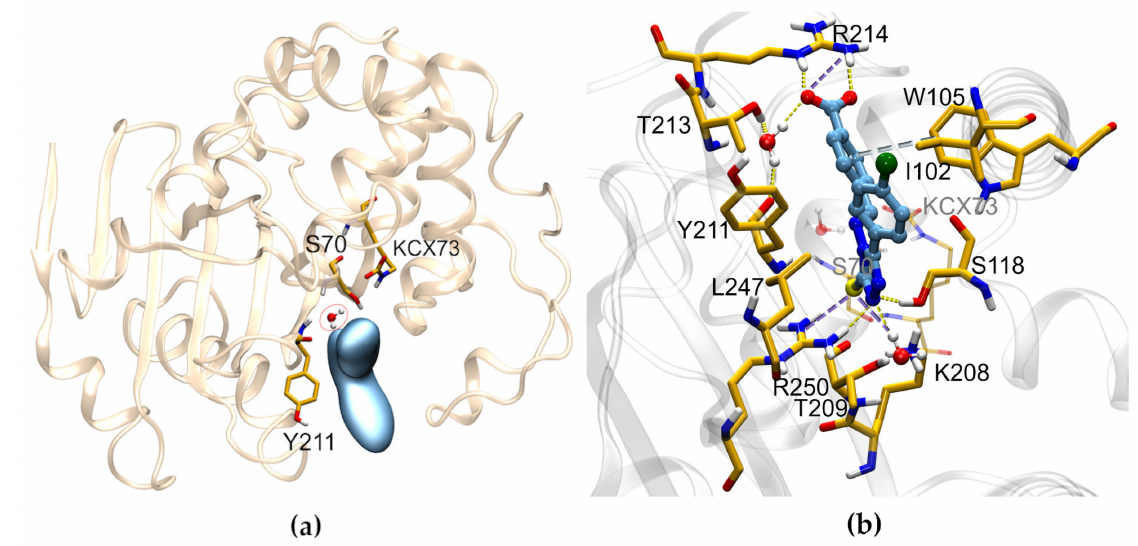
Figure 13. X-ray cocrystal structure of ID3 in complex with OXA-48 enzyme (PDB code: 7AW5), reported as cyan and yellow representations, respectively. ( a ) OXA-48 catalytic pocket occupied by ID3 (cyan surface). Carboxylated Lys73 (KCX73), catalytic Ser70 and Tyr211 (oxyanion hole), and the catalytic water molecule (red circle) are reported. ( b ) ID3 and the most relevant residues of the binding pocket. Hydrogen bonds, electrostatic and π – π interactions are represented as yellow, purple, and grey dashed lines. For the sake of clarity, some portions of the protein have been